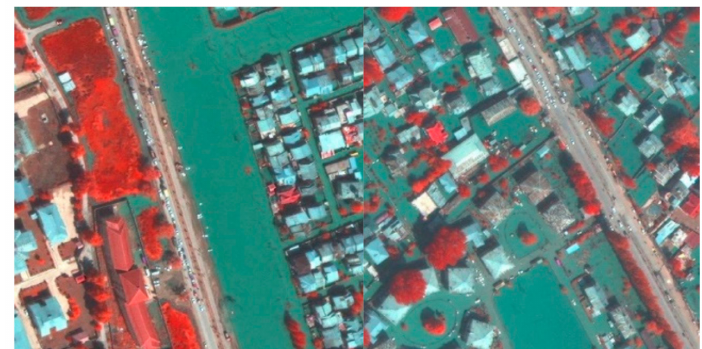
Figure 15. Remote sensing scenes depicting urban floods captured by WorldView-2 of Sringar, India, during the floods of September